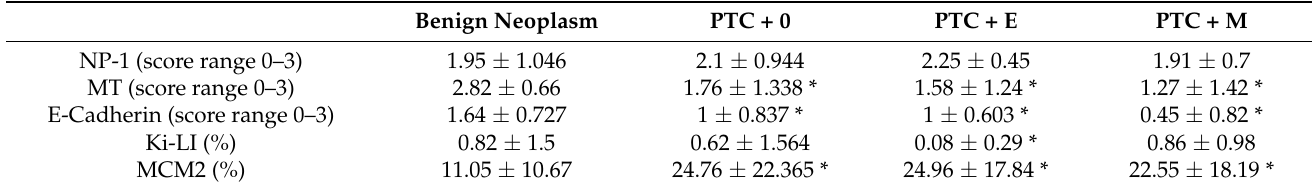
Table 2. Immunohistochemistry staining intensity score of the studied proliferative biomarkers.